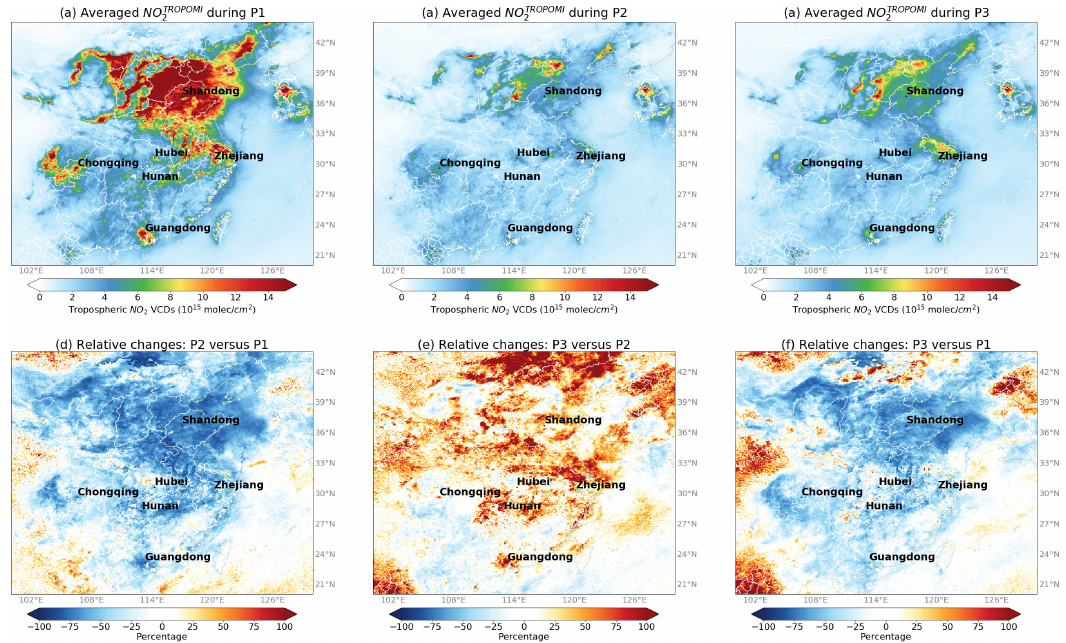
Figure 1. ( a – c ) TROPOMI tropospheric NO 2 VCDs (NO 2TROPOMI ) averaged during the three periods. ( d – f ) Relative changes between periods.